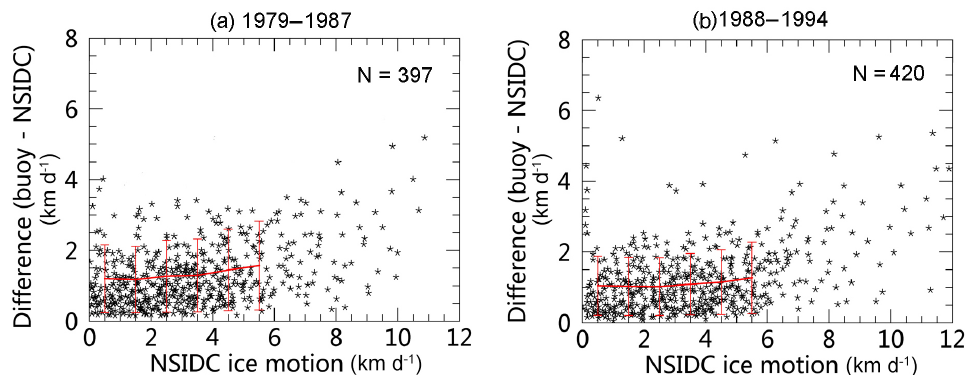
Figure 2. Sea ice motion difference between IABP and NSIDC products at different ice drift speeds during (a) 1979–1987 and (b) 1988– 1994 periods. The mean (red line) and standard deviation (error bar) of the difference at different speed ranges (from 0–6kmd − 1 with a bin interval of 1kmd − 1 ) are shown. N is the data pair number in comparison.